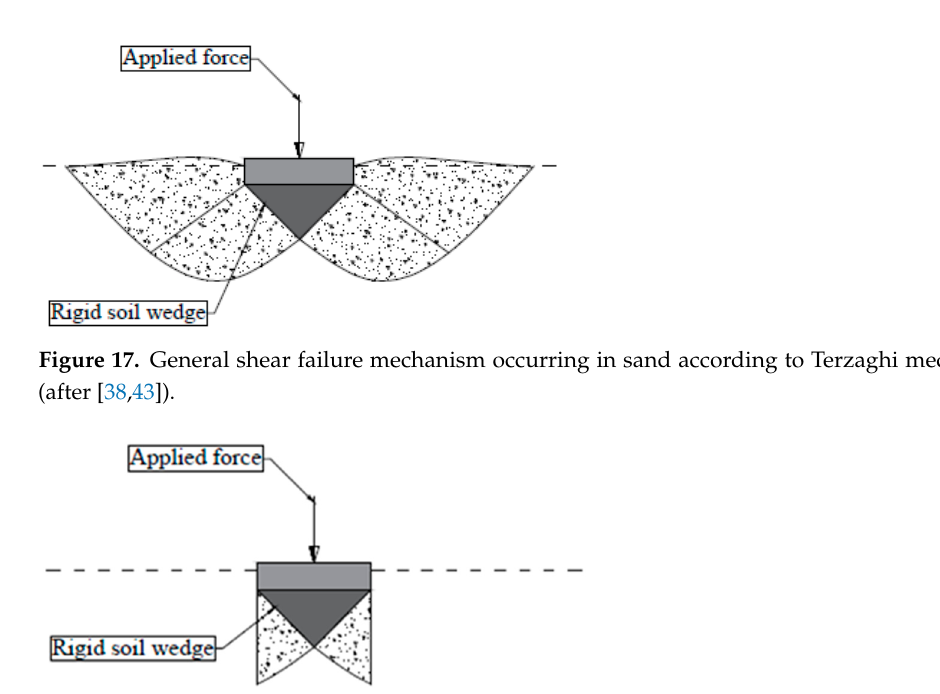
Figure 18. Punching shear failure mechanism occurring in clayey silt according to Terzaghi mechanism (after [38,43]).